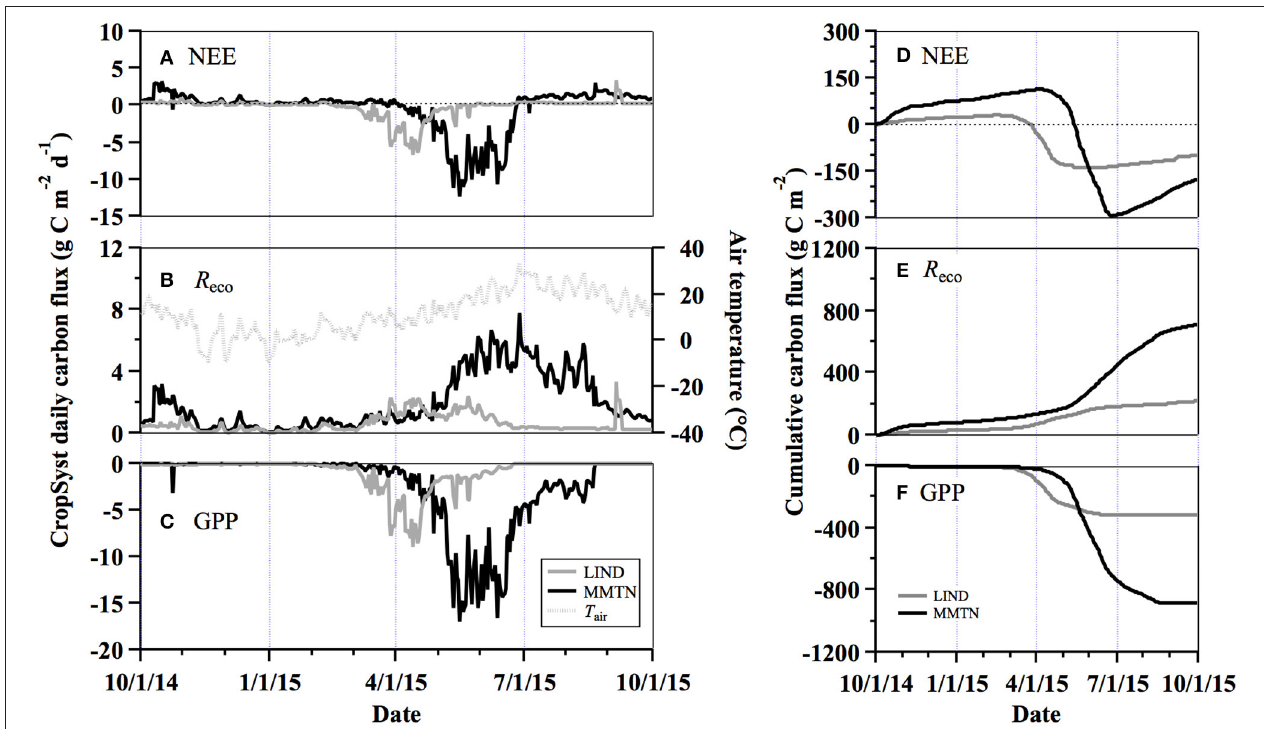
FIGURE 7 | CropSyst daily (A–C) and cumulative (D–F) net ecosystem exchange of CO 2 (NEE), total ecosystem respiration ( R eco ), and gross primary productivity (GPP), at the low-rainfall (LIND) and high-rainfall (MMTN) winter wheat fields during the water year of 2015. Daily air temperature ( T air ) was only plotted for LIND.